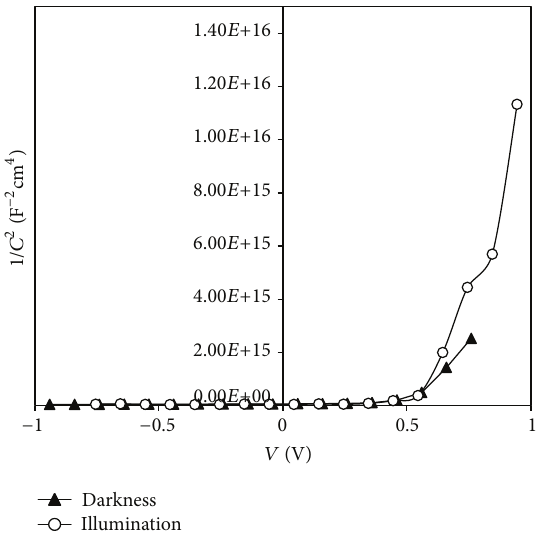
Figure5: 𝐶 - 𝑉 curvesofITO/EB-MWCNT/ZnO-rhodamineB/ITO structure under darkness and illumination.